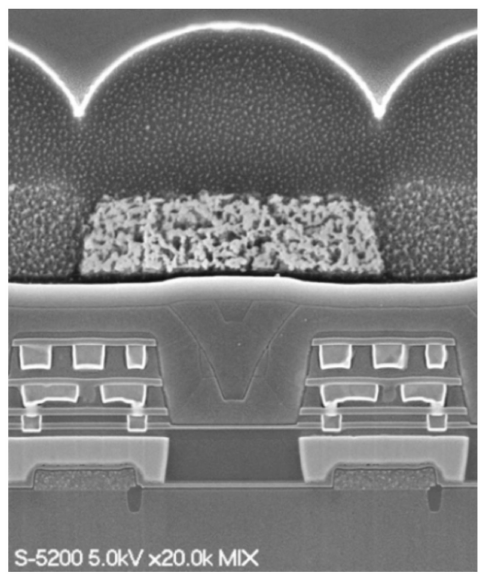
Figure 9. Cross-section of 2.5 µ m GS pixel.